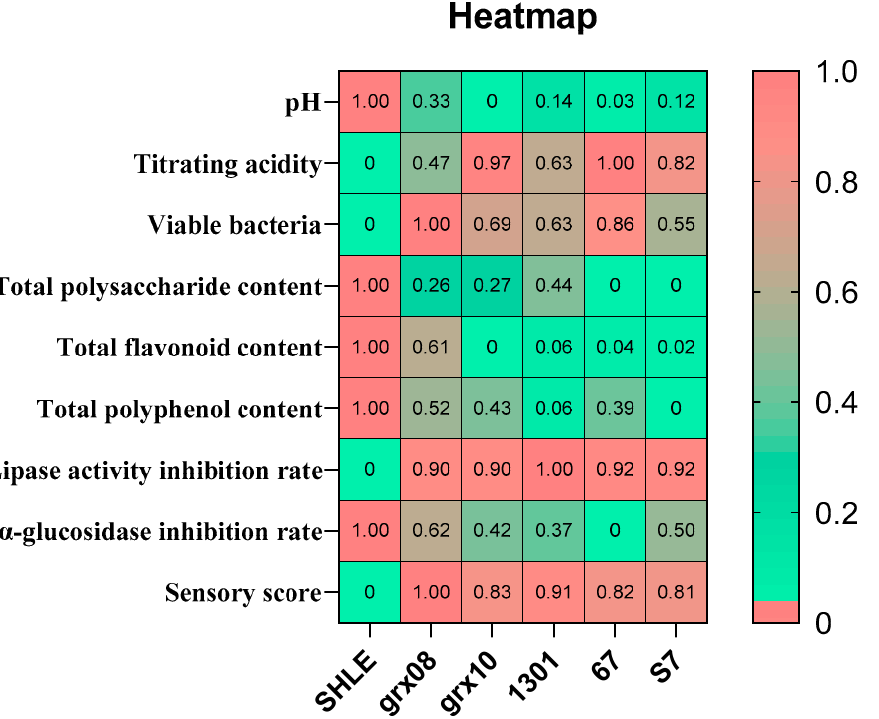
Figure 6. Heatmap analysis of the substance content, the activity of inhibiting energy-related enzymes and the sensory flavor of SHLE by the fermentation of different strains. The data were processed by min–max normalization with the formula (x − min)/(max − min). The changes in color and shade from green to red represent the magnitude of the value from 0 to